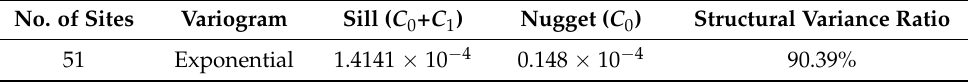
Figure 7. Fitting results of WEEE return with exponential variogram for J company. Table 5. Quantitative analysis results of exponential variogram of WEEE return for J company.